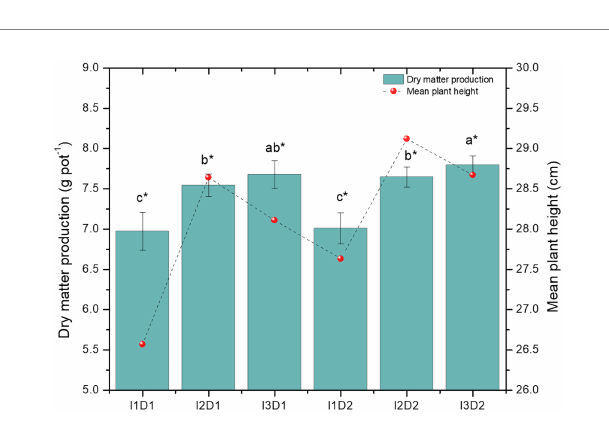
FIGURE 5 Effect of halotolerant microbial consortia dosage on growth of Vigna mungo L. under salinity. I 1 – Control; I 2 – Microbial consortium I; I 3 – Microbial consortium II and D 1 -2 kg of bioformulation per ha; D 2 -4